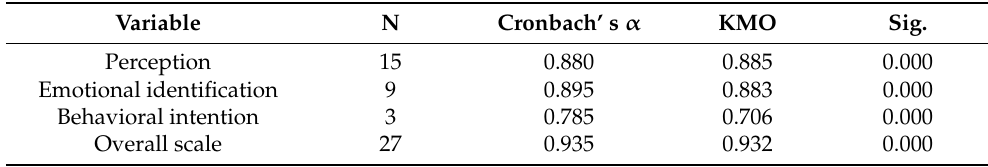
Table 3. Reliability and validity test of scale.